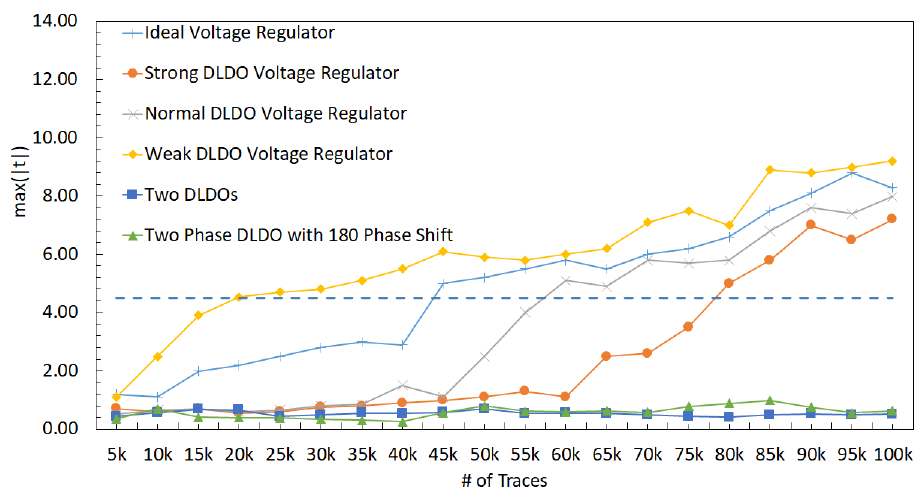
Figure 21. t -test value vs. number of traces when R 1 is 500 Ω . Table 2. The comparison of this work with other methods where implementation is the method used and minimum number of traces for leakage is the number of traces where the t -test passes threshold